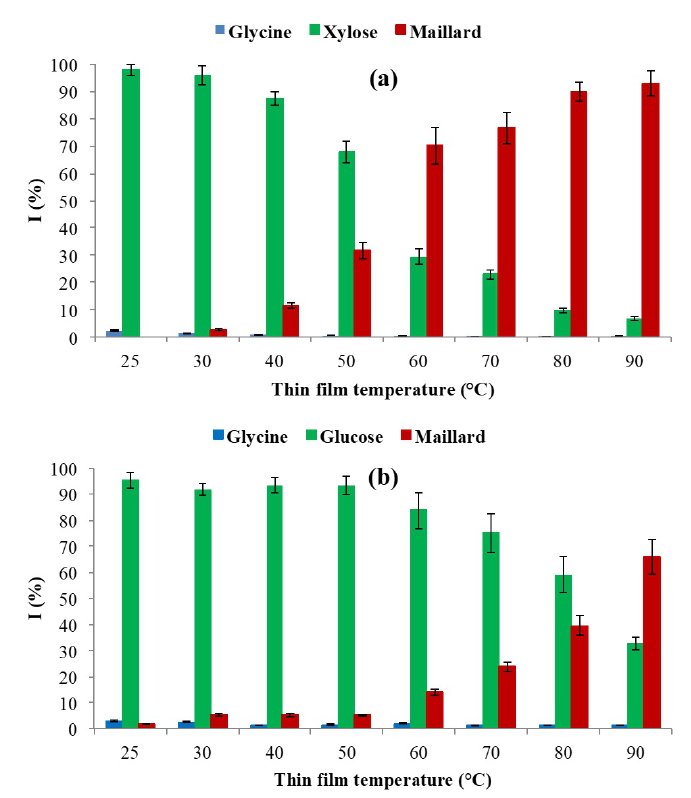
Figure 4. The reactants and Maillard reaction products (%) versus thin film temperatures ( ◦ C):